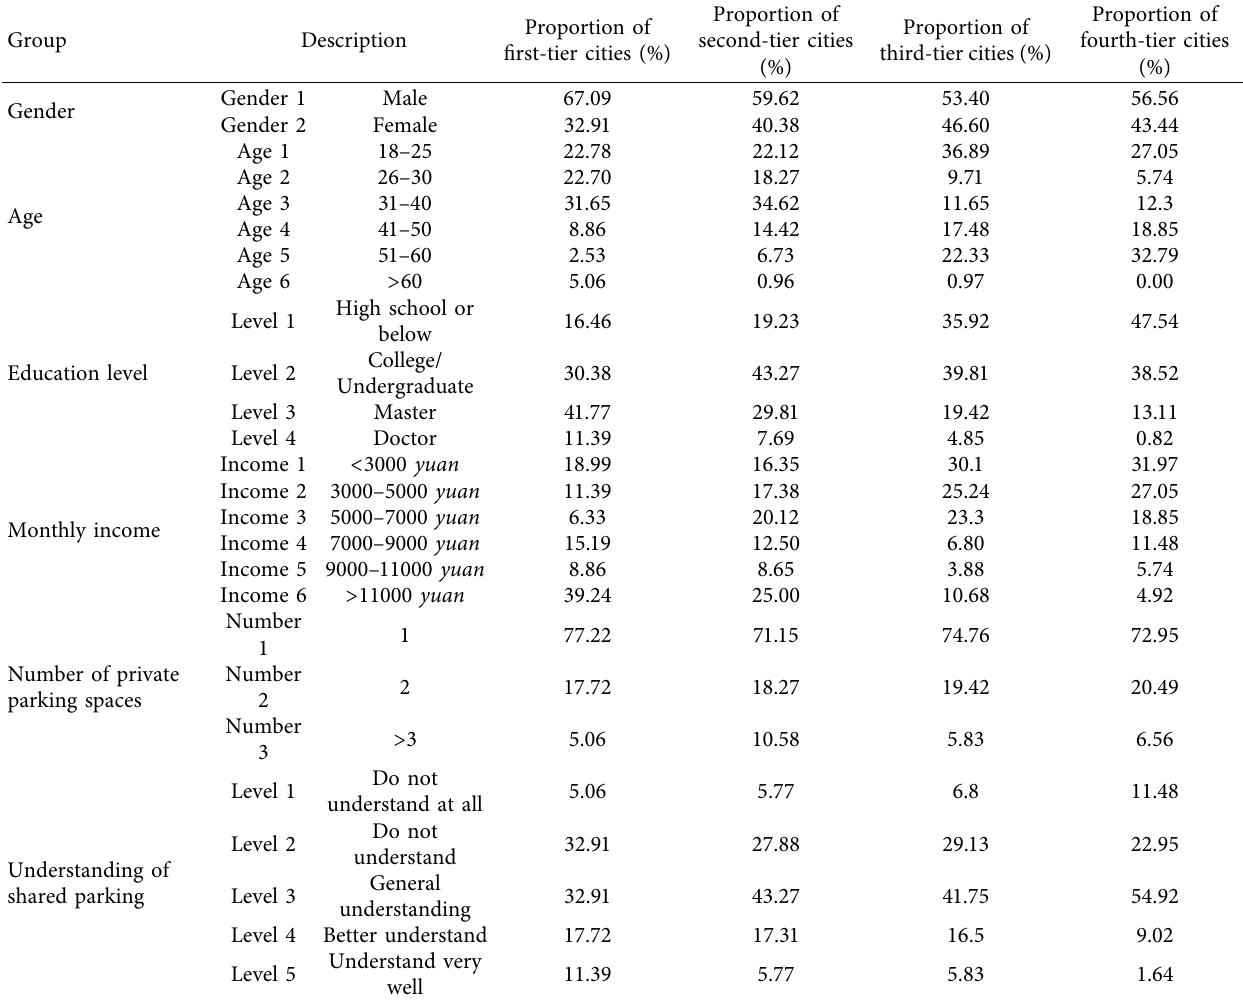
Table 2: Personal attribute information statistics of